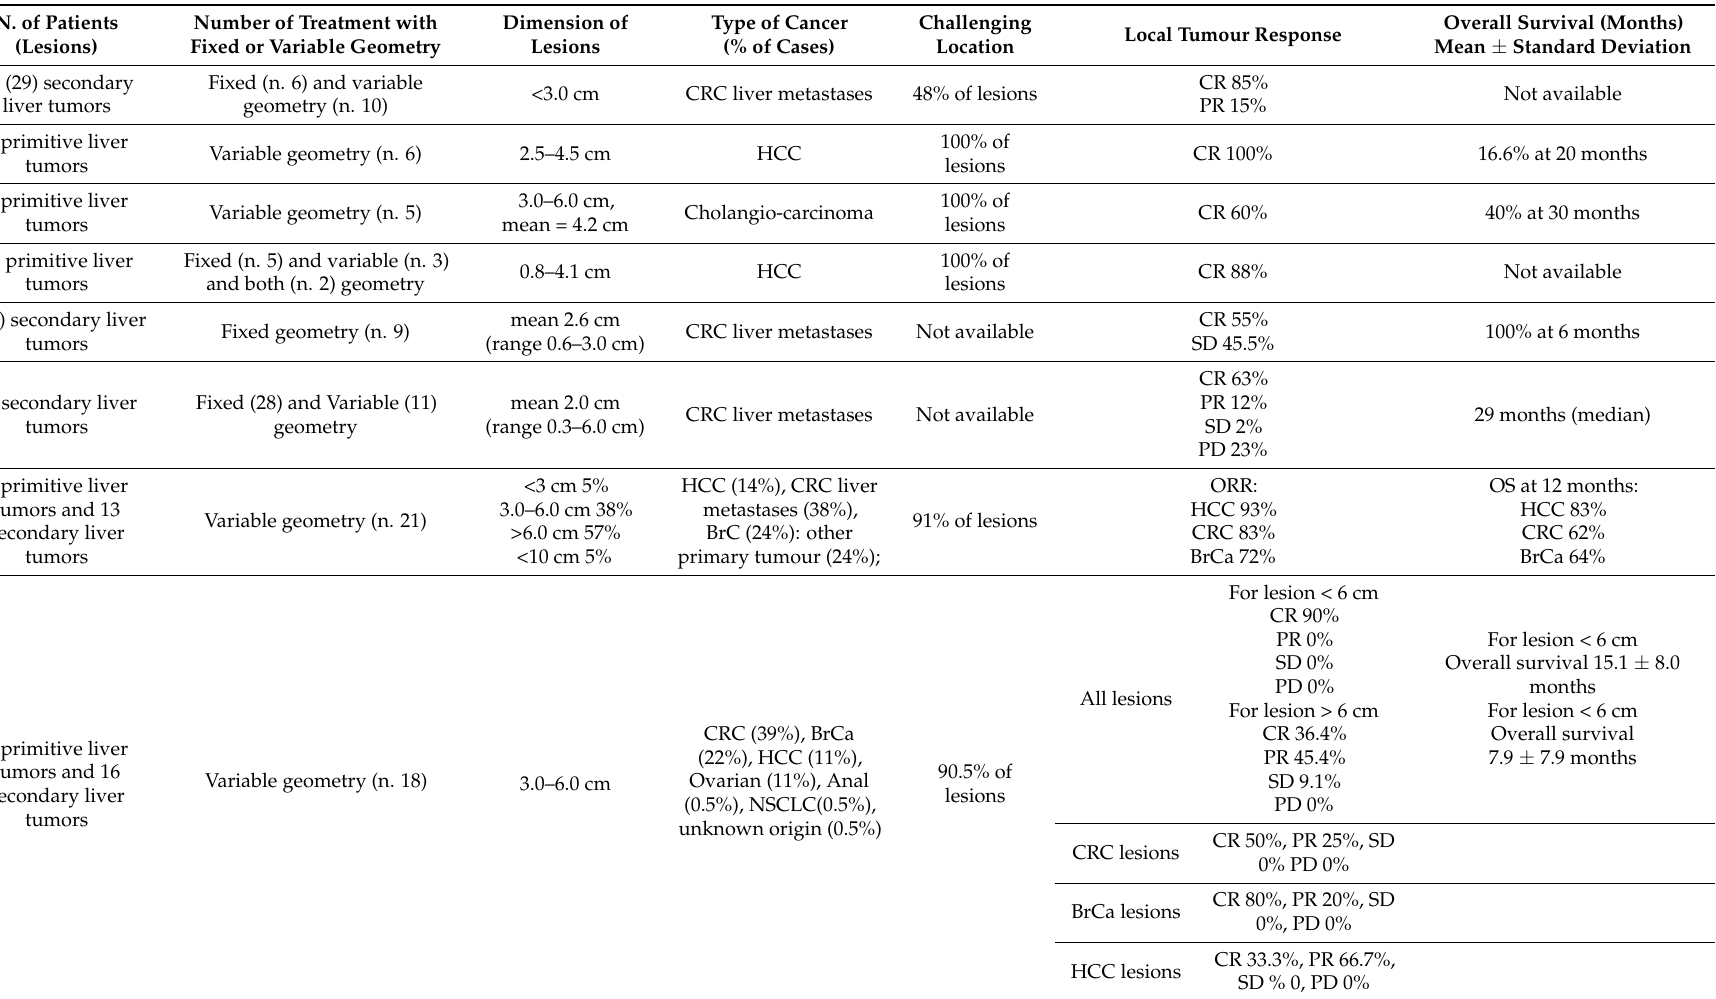
Table 1. Summary table of the studies analysed in this